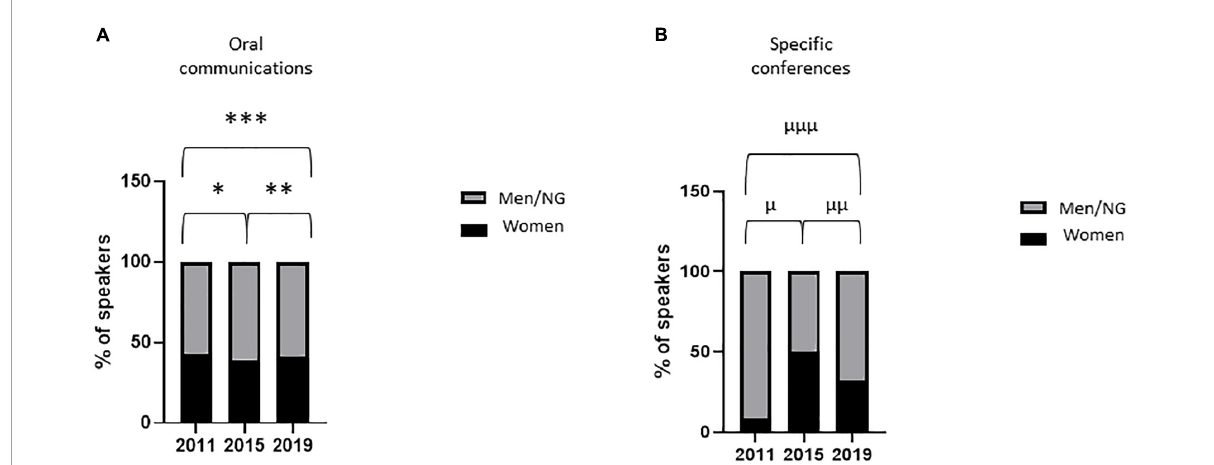
FIGURE1 Women speakers in major oral sessions. Proportion of women speakers in major oral sessions [ (A) oral communications; (B) specific conferences] during the three congresses. Variables are presented as percentages. After contingency analysis, variables were compared by